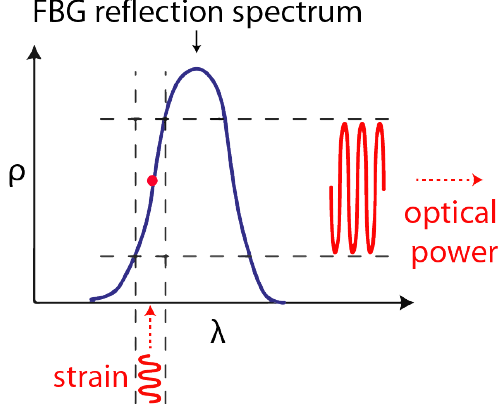
Figure 9. Increased sensitivity using the reflectivity